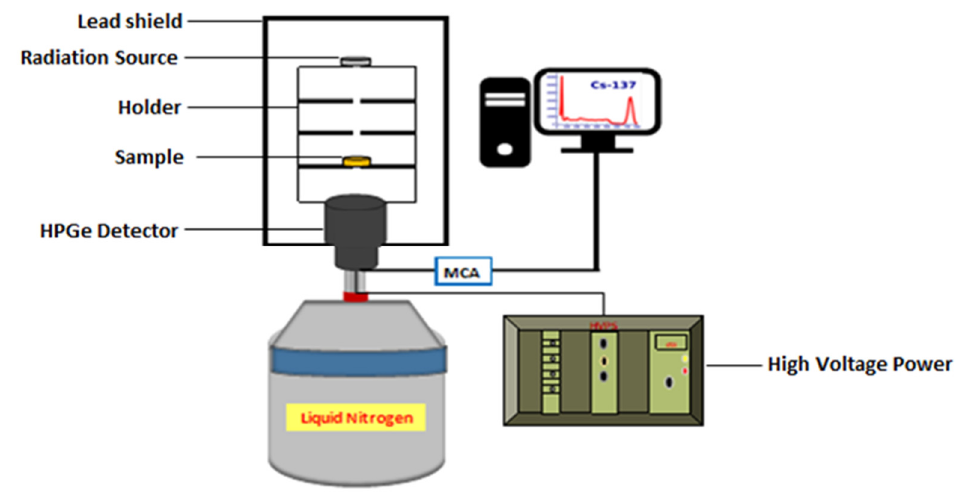
Figure 1. A schematic diagram of the experimental arrangement for gamma-ray measurements.